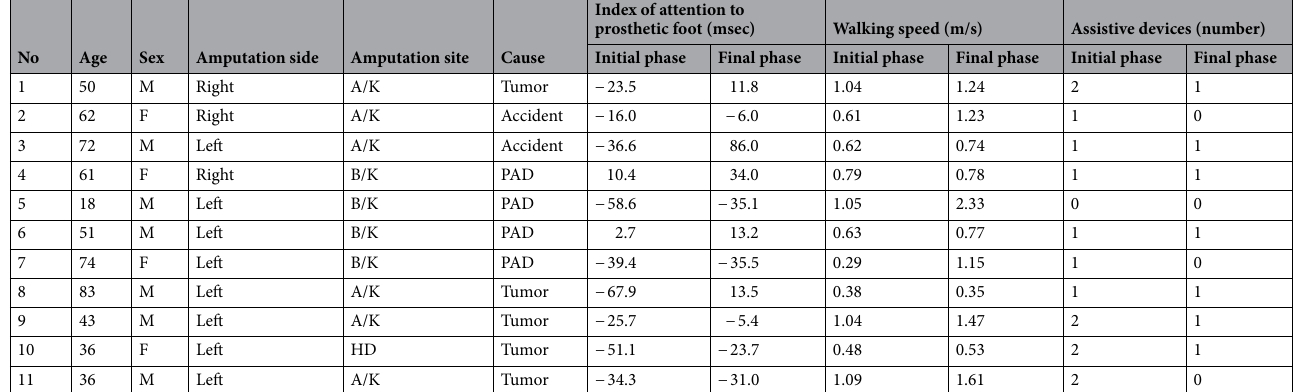
Table 1. Clinical characteristics of the patients. M Male, F Female, A/K Above-knee amputation, B/K Below- knee amputation, HD Hip disarticulation amputation, PAD Peripheral vascular